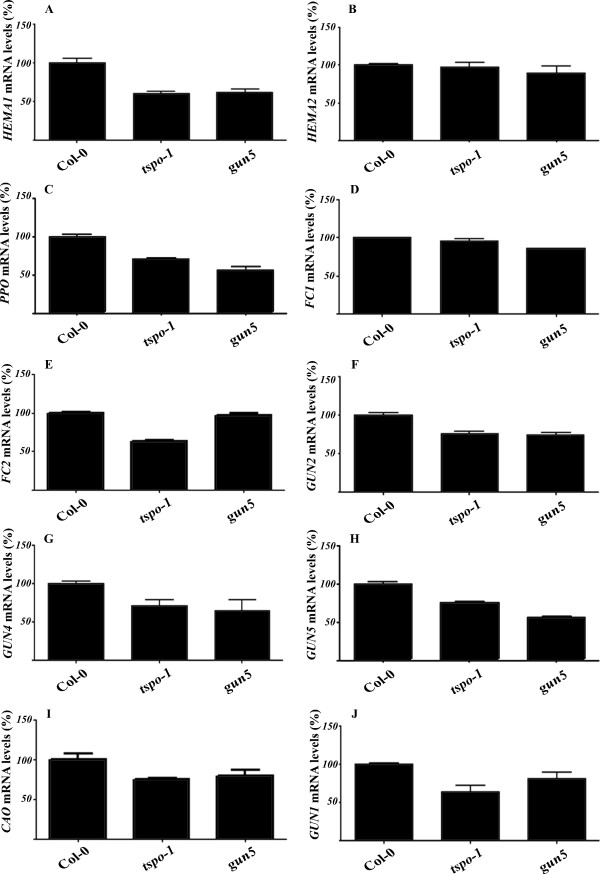
Expression of tetrapyrrole biosynthesis genes in tspo-1 mutant. qRT-PCR analyses of tetrapyrrole biosynthesis genes in Col-0, tspo-1 and gun5 5-days-old seedlings grown in constant light. Relative amounts were calculated and normalized relative to Col-0 non-treated (100%). With the exception of HEMA2 and FC1, all the genes have been show to be regulated by light. The data are presented following the enzymes order in the tetrapyrrole biosynthesis. The ACTIN and 18S rRNA genes were used as control. ACTIN, At3g18780; 18S rRNA, At3g41768; (A) HEMA1 (Glutamyl-tRNA reductase 1 - At1g58290) (B) HEMA2 (Glutamyl-tRNA reductase 2 - At1g04490); (C) PPO (Protoporphyrinogen oxidase - At4g01690); (D) FC1 (Ferrochelatase 1 - At5g26030); (E) FC2 (Ferrochelatase 2 - At2g30390); (F) GUN2 (Heme oxygenase 1 - At2g26670); (G) GUN4 (Regulator of Mg-porphyrin synthesis - At3g59400); (H) GUN5 (Mg-chelatase subunit H - At5g13630); (I) CAO (Chlorophyllide A oxygenase - At1g44446); and (J) GUN1 (Pentatricopeptide repeat (PPR) protein - At2g31400). Data shown represent mean values obtained from independent amplification reactions (n = 3) and biological replicates (n = 2). Relative expression levels were calculated. Bars represent the standard error of biological replicates.